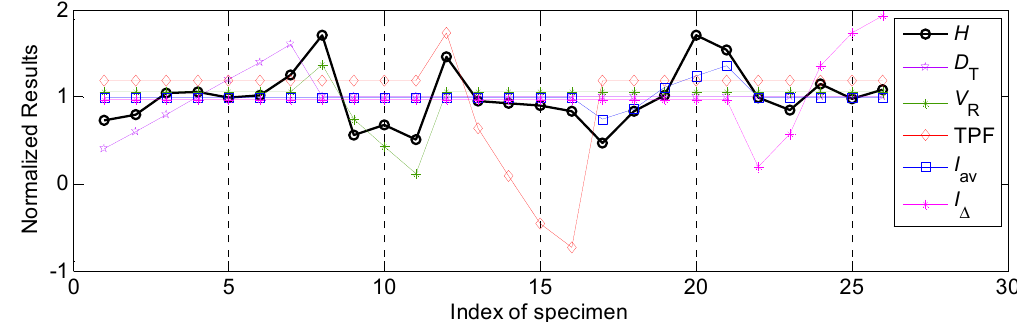
Figure 9. The normalized results of various process parameters and penetration after linear